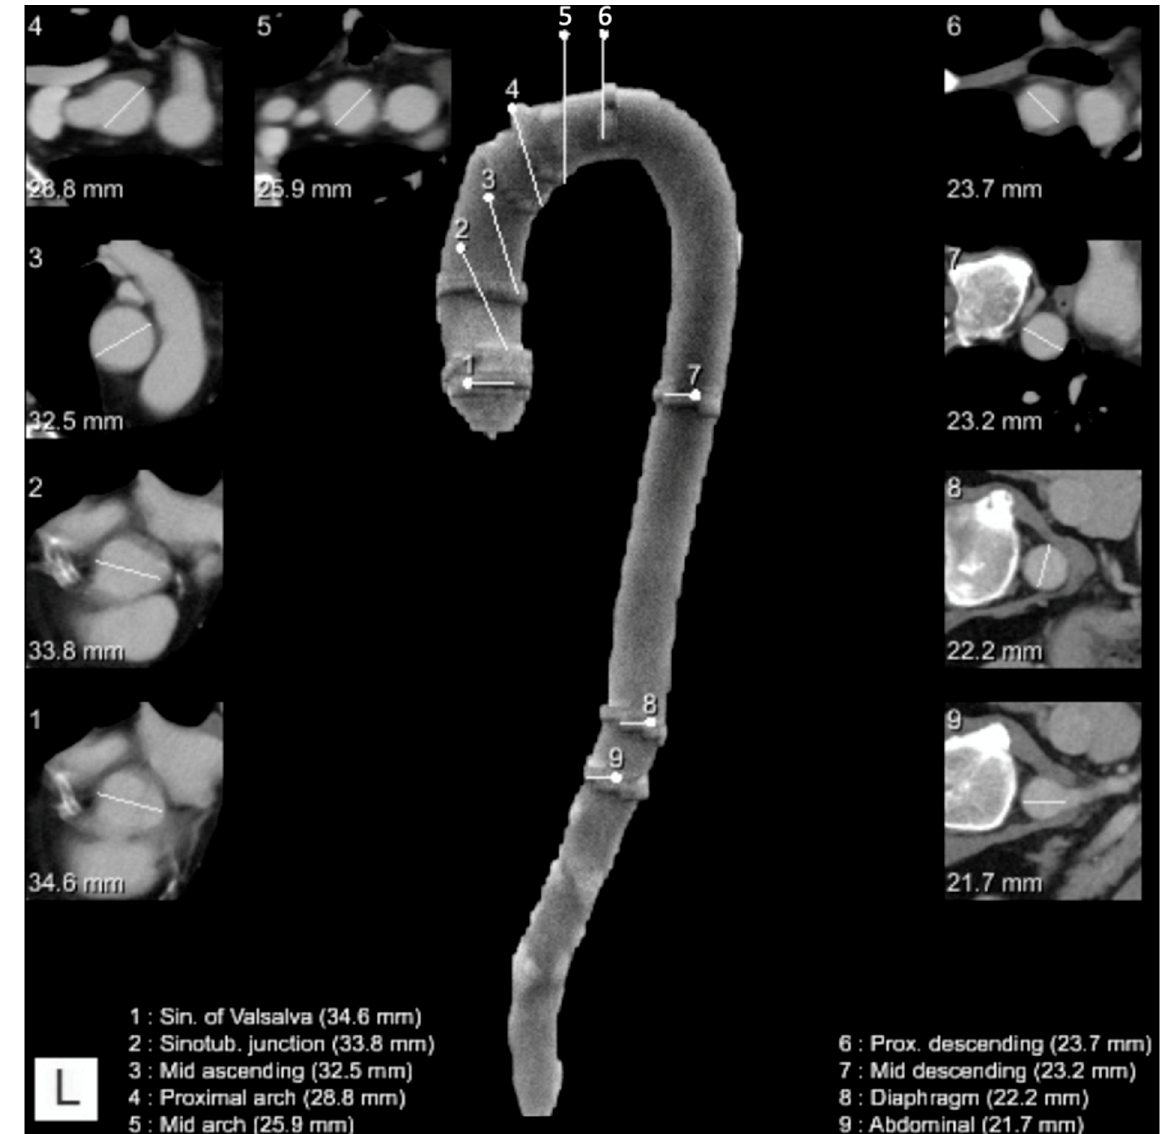
4 of 12 Figure 1. Deep image-to-image network (DI2IN). The front part is a convolutional encoder-decoder network with feature concatenation, and the backend is a deep supervision network through multi-